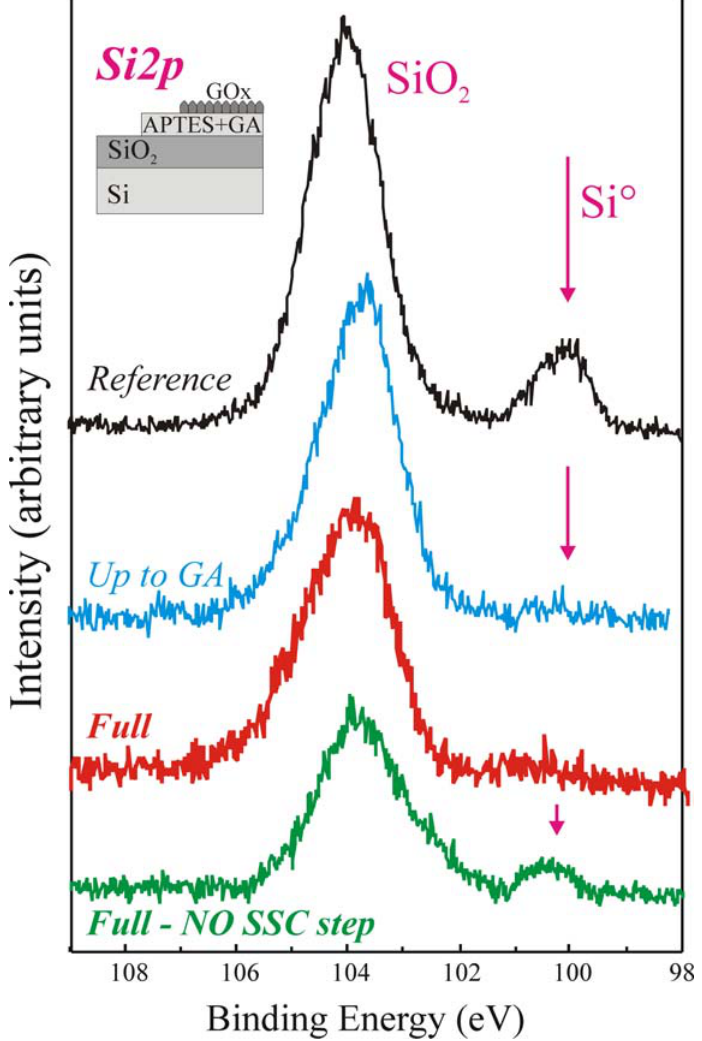
Figure 3. High statistic acquisition mode XPS Si2 p spectral regions of the reference (black line), up to GA (blue line), fully processed with SSC (GOx molecule, red line, Full) and fully process without SSC (green line, Full-NO SSC step) samples. A schematic of the immobilization steps is also reported (top